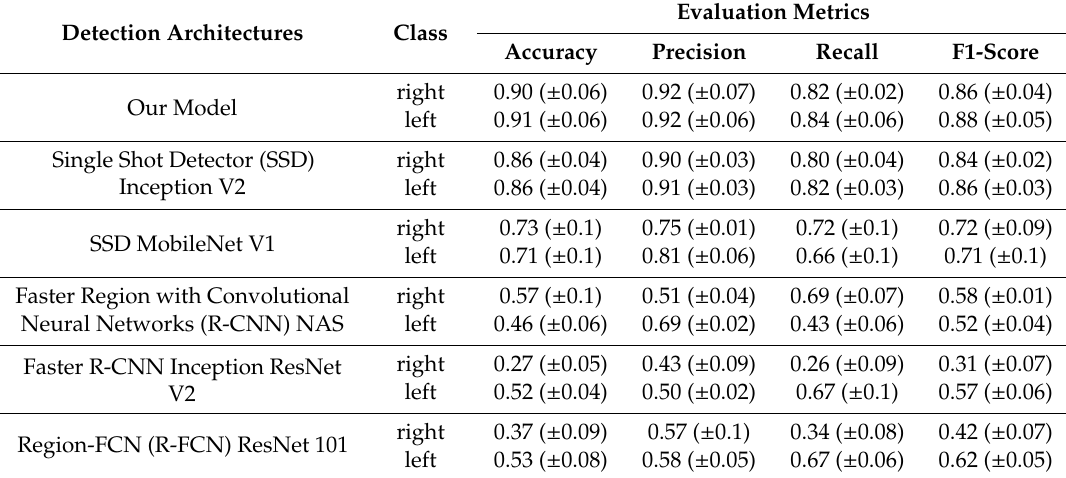
Table 2. Evaluation metrics results on image-wise testing.